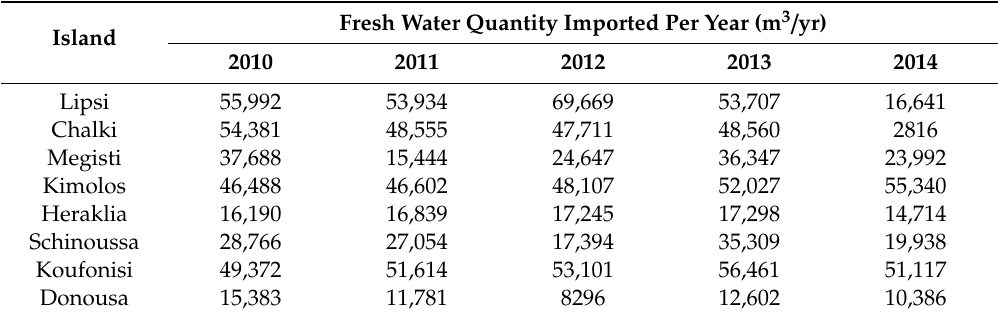
Table 1. Volume of freshwater shipped to selected Greek islands of the Aegean Sea during 2010–2014 1 .